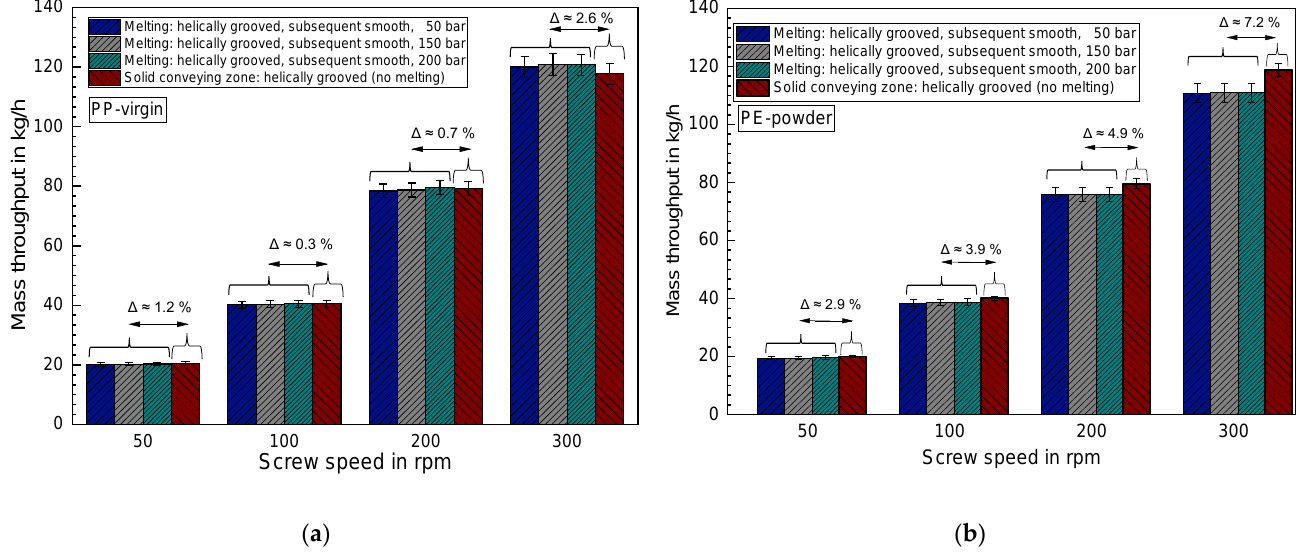
Figure 13. Comparison of the mass throughput in a whole extrusion set-up at different throttle die pressures to the throughput in a mere helically grooved solid conveying zone ( a ) for the virgin PP and ( b ) for the powdery PE.